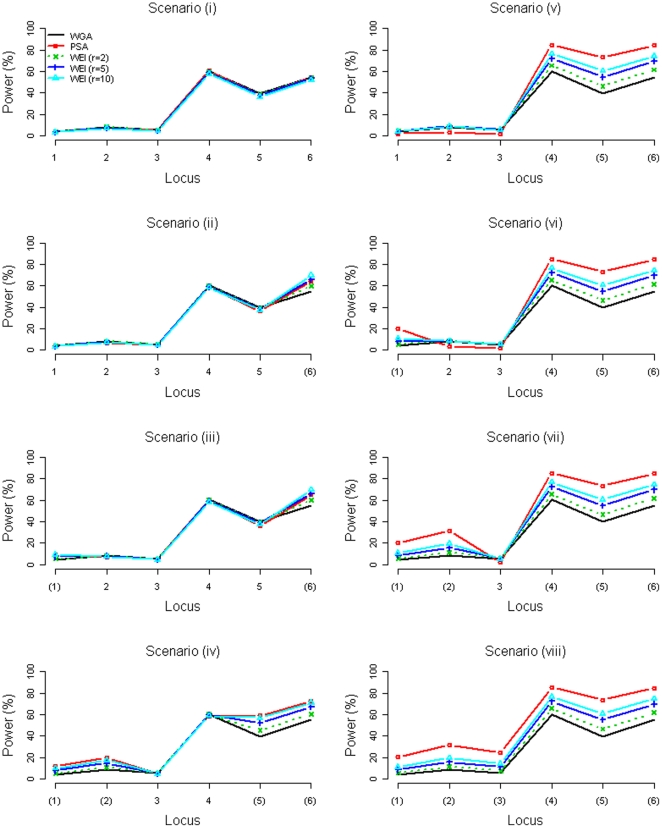
Power comparison between the WGA, the PSA, and the WEI (r = 2, 5, 10) when six 20-Mb regions were prioritized (with adjustment to the PSA).A locus with parentheses indicates that the disease locus was included in the prioritized subset.